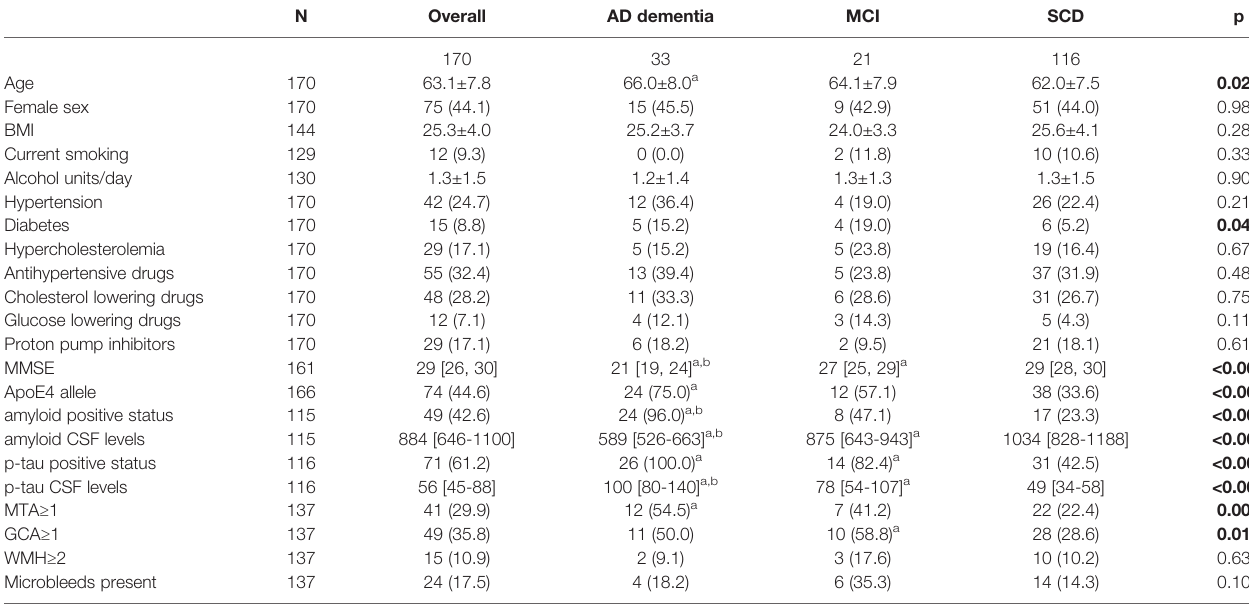
TABLE 1 | Patient characteristics.